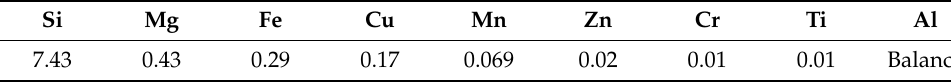
Table 1. Chemical composition of the A356 alloy (wt%). Si Mg